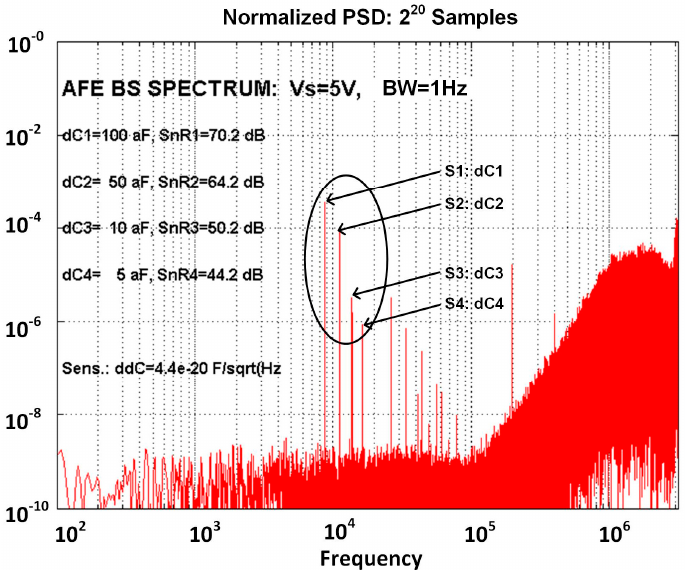
Figure 9. Simulated spectrum at the output of the ASIC with four differential sensors connected to one measurement channel, where each sensor is connected to excitation signal with 5 V amplitude and different frequencies. The amplitudes of spectral components correspond to different capacitance differences; for example the 4th sensor has capacitance difference of 5 aF which corresponds to the smallest spectral line (S4: dC 4 at frequency 16 kHz) with SnR of 44 dB, which leads to possible detection sensitivity of 44 zF/ √ Hz.